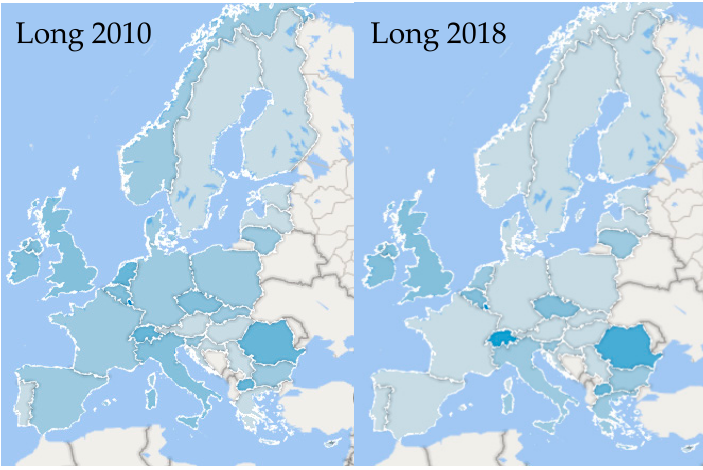
J. Risk Financial Manag. 2020 , 13 , x FOR PEER REVIEW Figure 9. Number of first precedencies by country—geospatial distribution in 2010 and 2018.